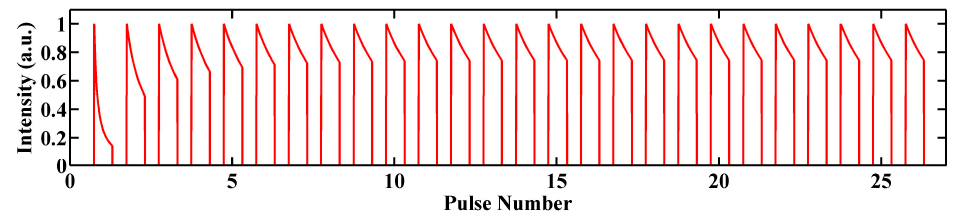
Figure 3. Pulse shape evolution during the iteration.